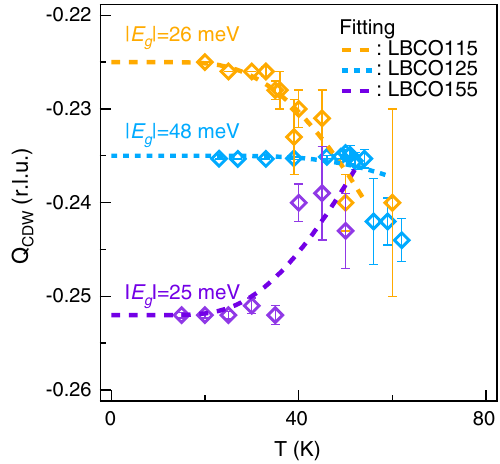
FIG. 6. Entropy-driven self-doping model. The data in Fig. 4(b) are fitted by using Eqs. (1) and